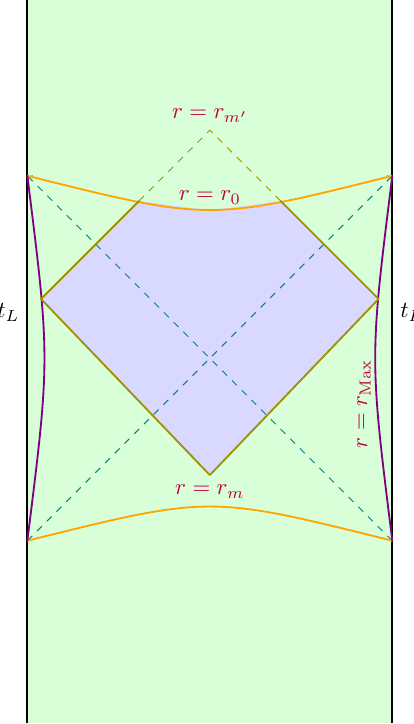
Fig. 1 Penrose diagram of AdS 2 geometry. The green area is covered by global coordinate while the diamond shown by dashed lines is cov- ered by Rindler coordinates.The WDW patch is shown by blue color. The inside cutoff r 0 is given by in terms of UV cutoff by r 0 r 2 at leading order. This figure is taken from the Ref.